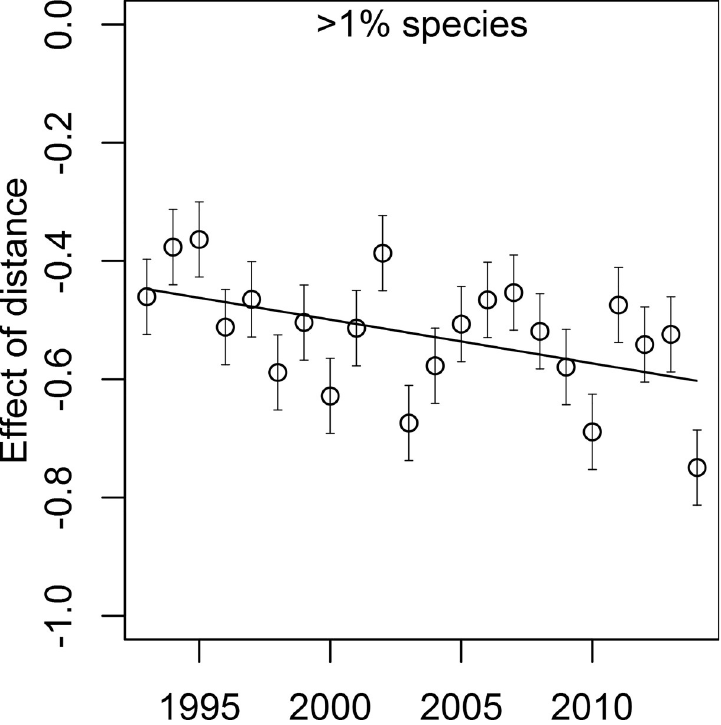
Fig 4. Magnitude of the standardized slope (the effect) relating distance (river km) to Bray-Curtis similarity over time. Estimated effect sizes (slopes) are derived from a multi-level model where slope was allowed to vary by year. Only species that made up at least 1% of the catch in at least one pool were included in this analysis.